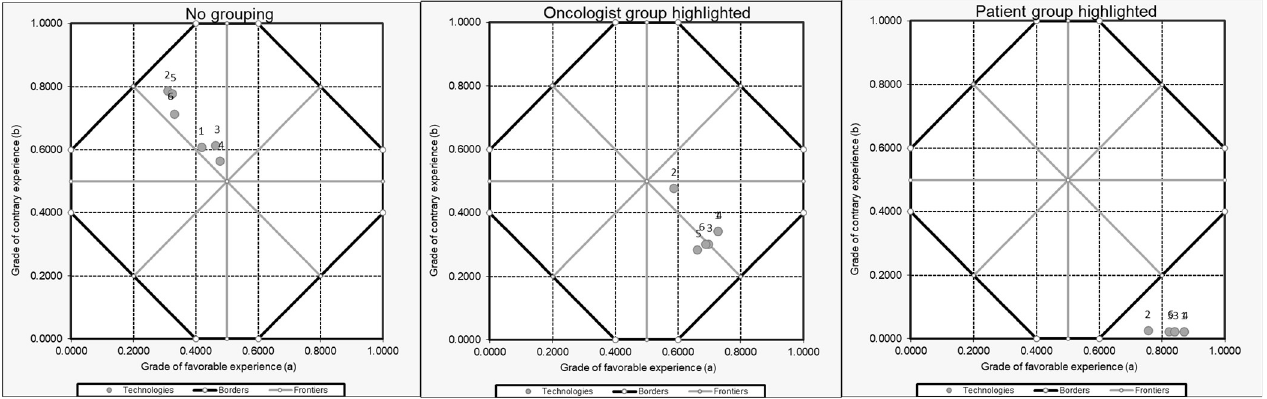
Fig 4. One-way sensitivity analysis on different expert group arrangements for first line metastatic colorectal cancer treatments. 1 = modified Flox (5FU, oxaliplatin, leucovorin); 2 = modified IFL (irinotecan, 5FU, leucovorin); 3 = modified FOLFOX6 (5FU, oxaliplatin, leucovorin); 4 = FOLFIRI (5FU, oxaliplatin, irinotecan, leucovorin); 5 = Panitumumab; 6 = Cetuximab.